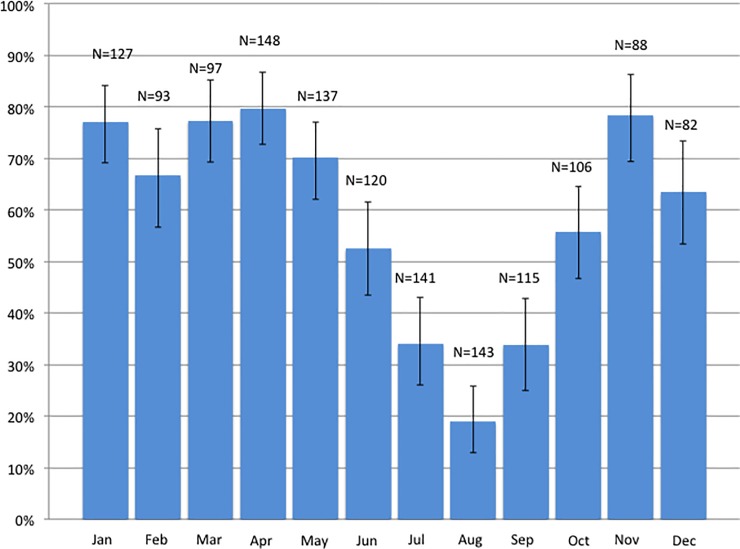
Proportion of pregnant women with vitamin D deficiency (<50 nmol/L) at the time of delivery according to month of sampling and total number (N) of samples collected per month.